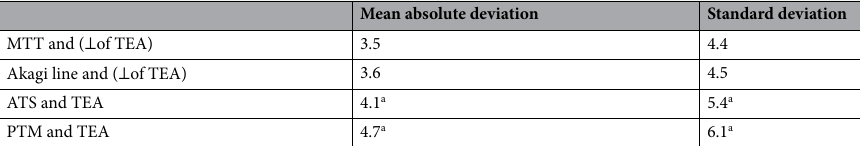
Mean absolute deviation Standard deviation